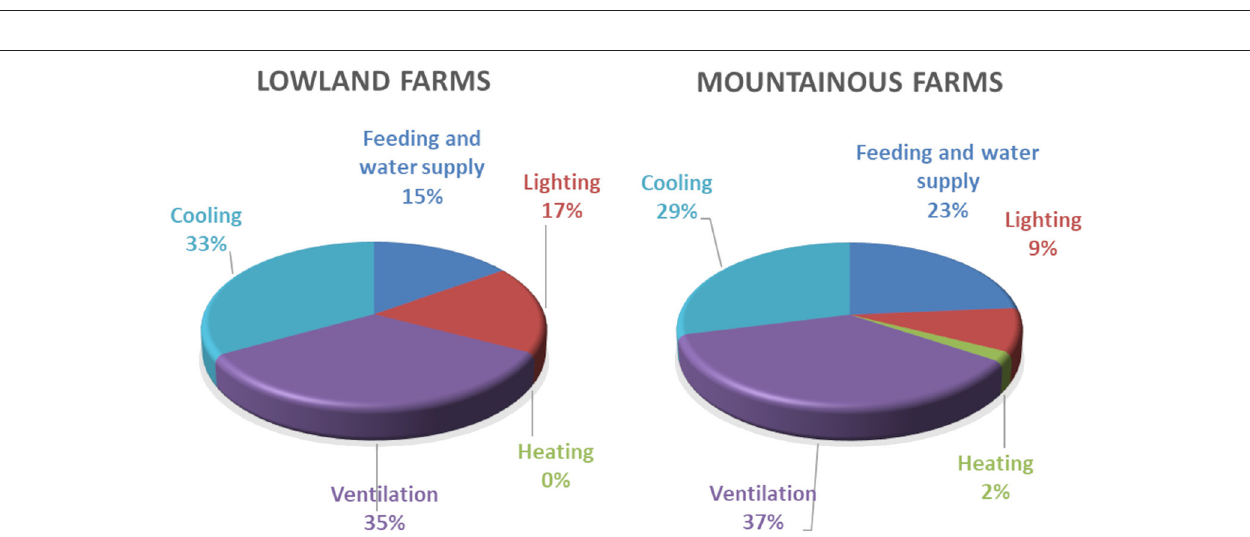
FIGURE 5 | Distribution of total final energy consumption in lowland and mountainous farms.